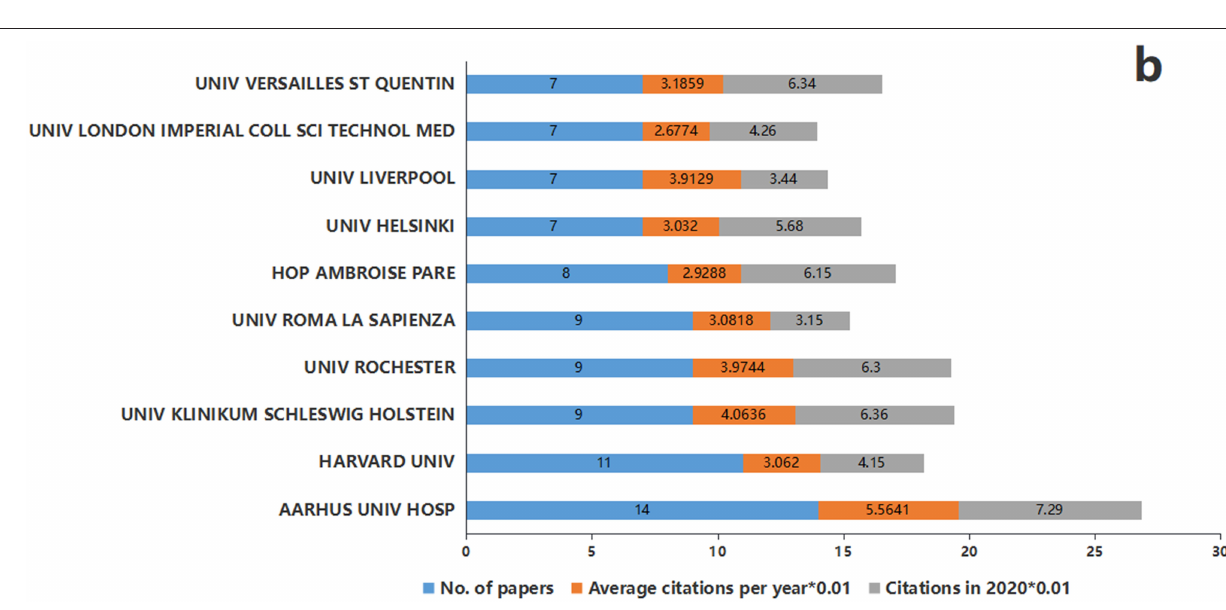
FIGURE 5 | Institutions with at least seven papers in the top 100 most-cited